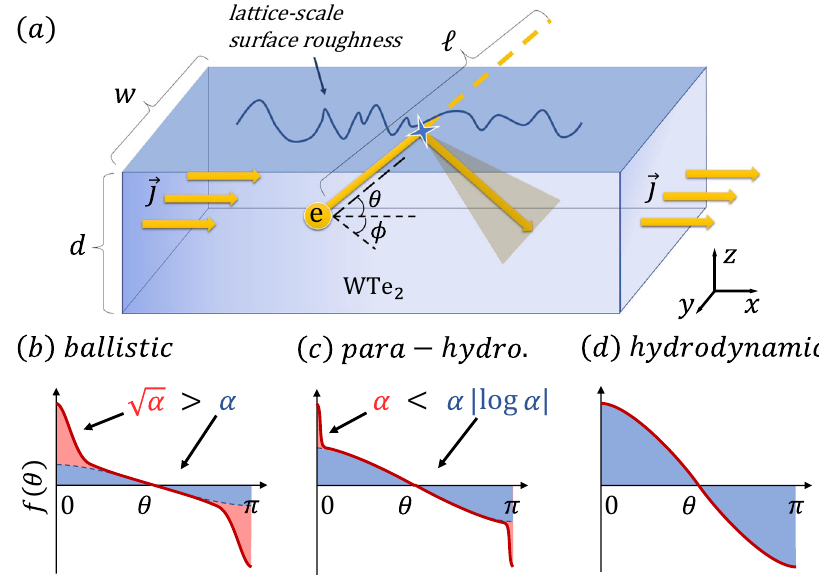
Fig. 1 | Phenomenology of para-hydrodynamics. a The current fl ows through a thin slab of thickness d ≪ w ≪ ℓ . Electrons scatter at the microscopically rough top and bottom surfaces with incident angle θ . Most trajectories are re fl ected almost specularly, leading to angular diffusion in θ , while few trajectories scatter ran- domly, thus dissipating momentum. b – d Comparison of the non-equilibrium dis- tribution functions f ( θ ) in different fl ow regimes (red curve). An approximate cosine that inscribes f ( θ ) for steep angles θ ≠ 0, π is shown as a blue shaded area,